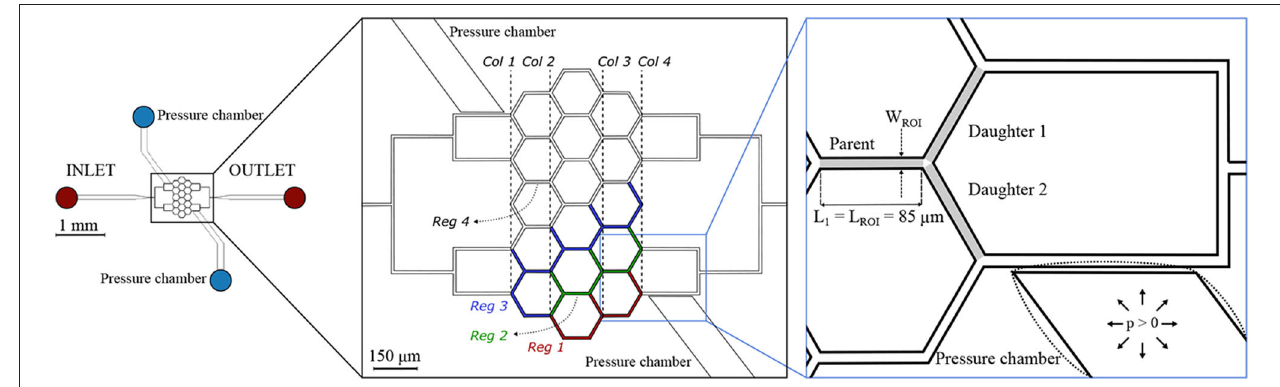
FIGURE 2 | Honeycomb network. Schematic of the microfluidic device (left) and magnified images (right) with a passive (solid lines) or inflated (dotted lines) pressure chamber. The inset on the right shows an example of a diverging bifurcation. Regions of interest (ROIs) for the parent and for the daughter branches are marked in light gray. The width of the ROI is W ROI 9.6 µ m , while the length is L ROI 85 µ m for all micro-channels. The device embeds two pressure chambers which are separated = = from the adjacent micro-channels by thin membranes with thickness t 1 5 µ m . For the interpretation of the results, four regions were defined: Reg 1 (red channels), = Reg 2 (green channels), Reg 3 (blue channels), and Reg 4 (white channels). A column ordering ( Col 1 ... Col 4) was defined to sort the diverging bifurcations.